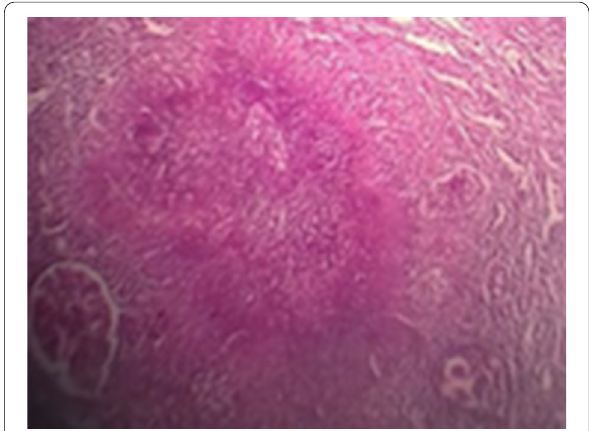
Fig. 2 Pathological examination of the specimen revealed a epithelioid cell granuloma with caseating necrosis. (Standard coloring HES. Magnification ×